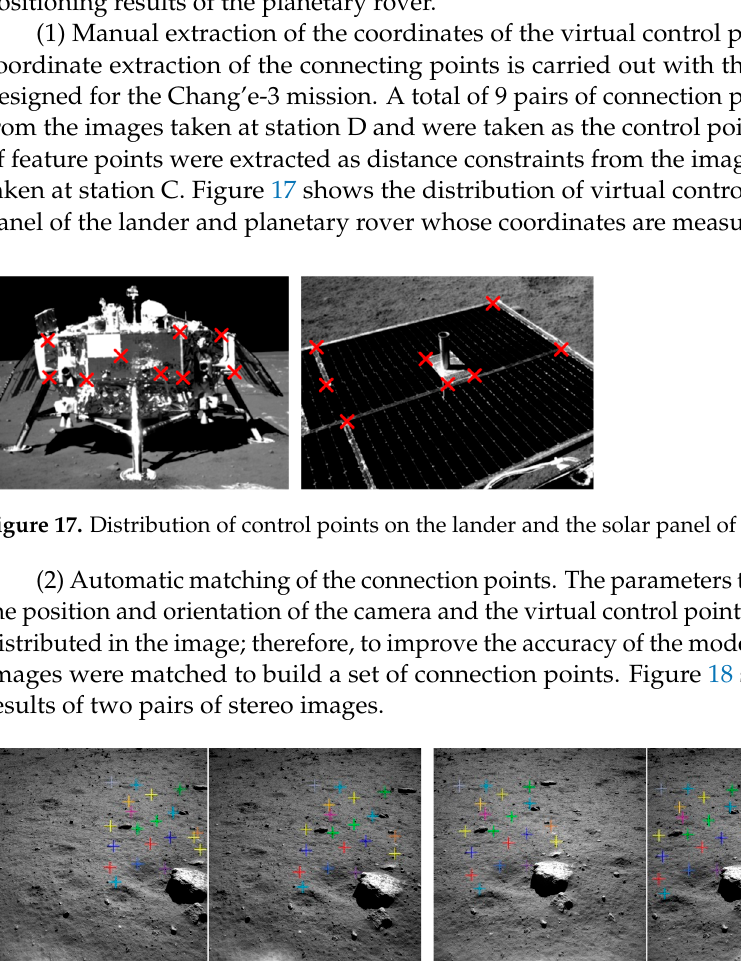
Figure 18. Matching results of connection points in images taken at adjacent stereo images (The same color represents the corresponding matching points).